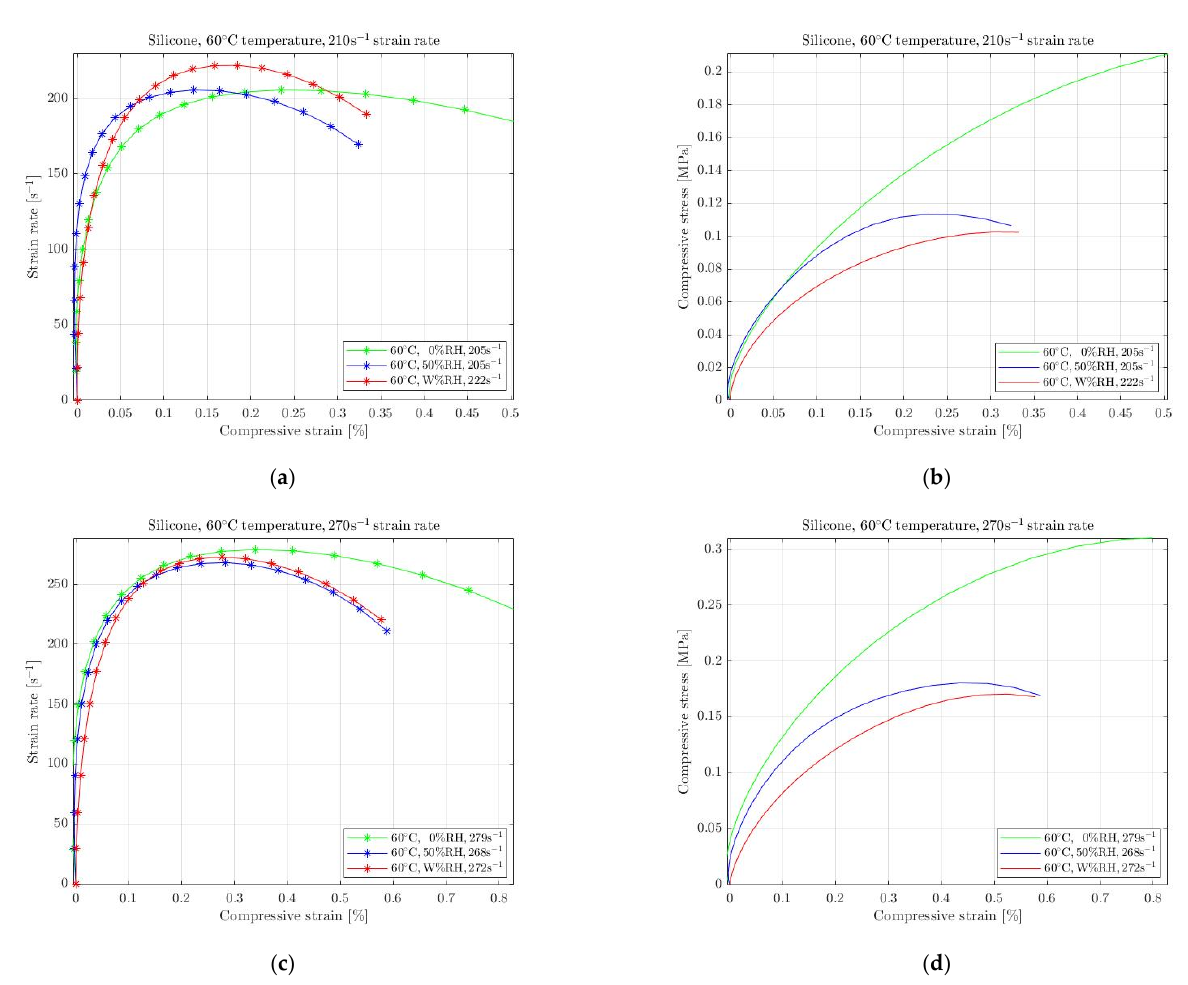
Figure 12. Strain rate vs. compressive strain ( a , c ) and compressive stress vs. compressive strain ( b , d ) of silicone under compression at 60 °C temperature with 0%, 50% and W% RH for 210 s − 1 ( a , b ), and 270 s − 1 ( c , d ) strain rate.